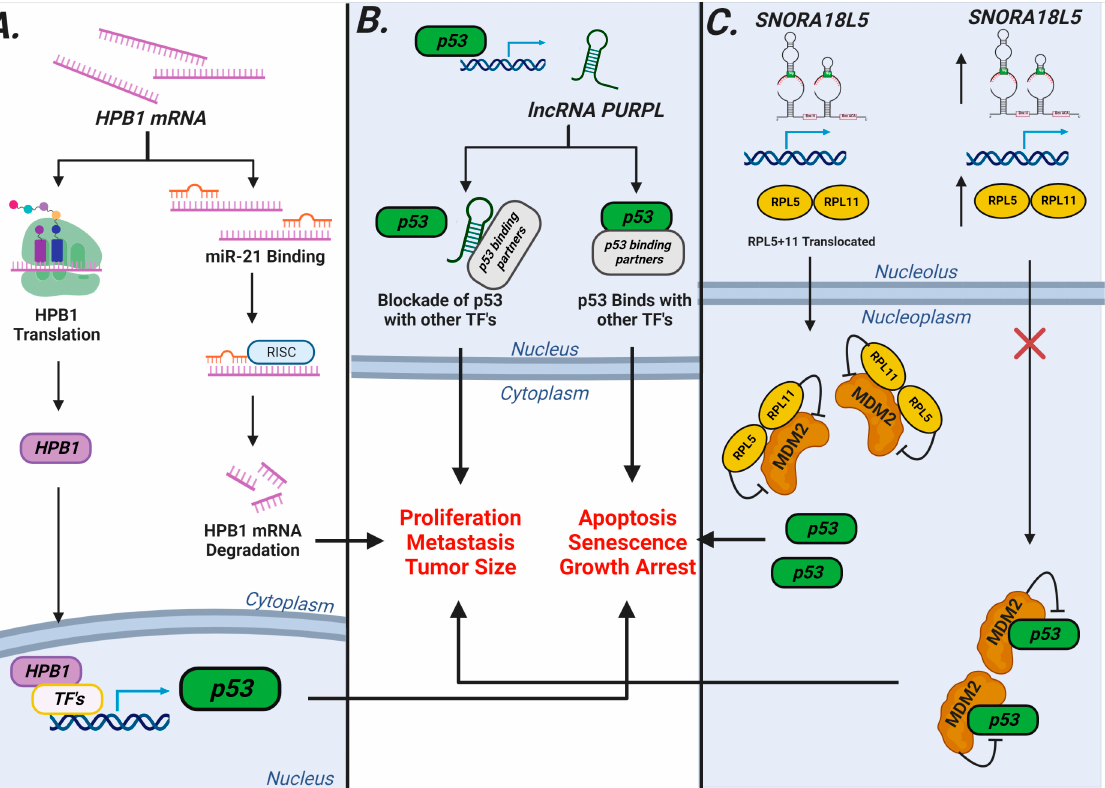
Figure 1. ncRNA’s impact on hepatocellular carcinoma. While the mechanisms of action of various classes of ncRNAs in the development and progression of HCC vary, they can have overlapping functions on important regulators of oncogenesis. This, in effect, leads to a complexity of interactions that are poorly understood. ( A ) miR21 is highly upregulated in HCC and acts on its target RNA, HPB1. HPB1 mRNA, when not marked for degradation by miR21, is translated in HPB1, which acts in concert with other transcription factors to increase production of p53. In the presence of miR21, HPB1 mRNA is degraded, leading to a lack of p53 production and, therefore, an increase in proliferation, metastasis, and tumor size. ( B ) lncRNA PURPL is also upregulated in HCC and acts in a similar manner to miR24 by binding components necessary for p53 regulation. In the presence of lncRNA PURPL, which is positively regulated by p53, p53 is unable to bind to its partners for downstream gene expression, leading to further oncogenesis. ( C ) SNORA18L5, an H/ACA box snoRNA that is upregulated in HCC, acts to increase transcription of rRNA RPL5 and RPL11. However, instead of these rRNAs translocating to the nucleoplasm and inhibiting MDM2-mediated degradation of p53, they are sequestered to the nucleolus, allowing for p53 degradation and, like other oncogenic ncRNAs, leading to further oncogenesis. Reprinted with permission from BioRender.com.